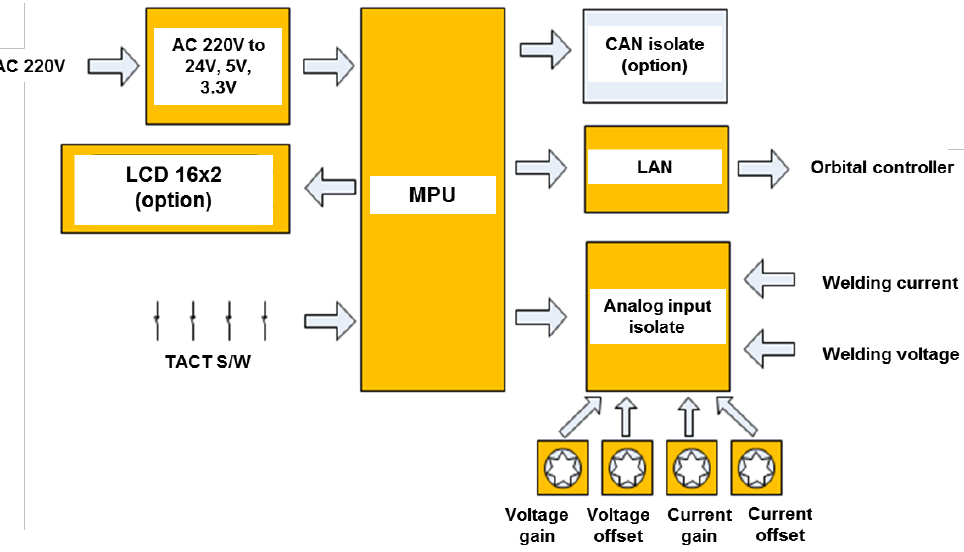
Figure 10. Welding monitoring module ( WMM) board block diagram.